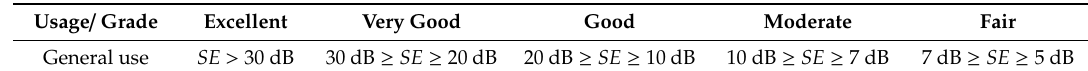
Table 4. Classification of EM SE values on textiles for general use